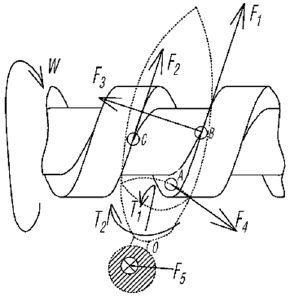
Figure 8. Interaction between spiral snapping roller and corn ear.